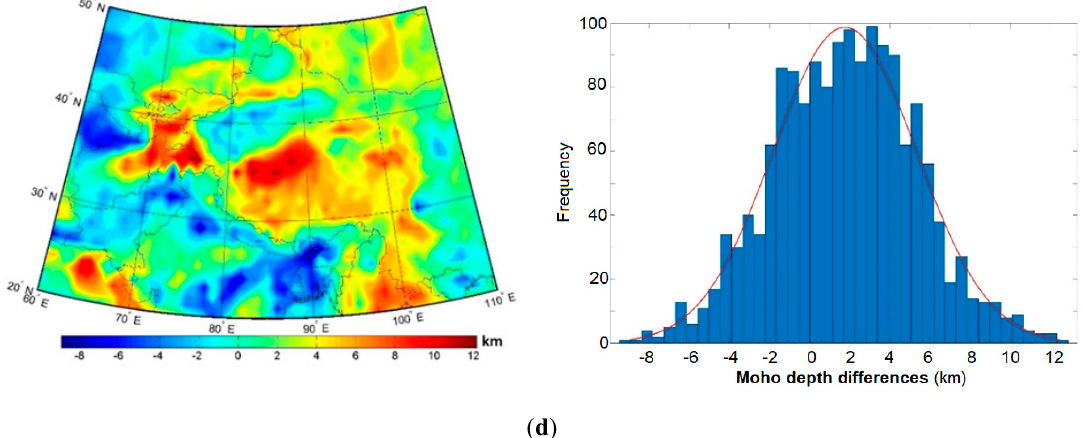
Figure 5. Moho depth differences: ( a ) seismic vs. combined, ( b ) seismic vs. CRUST1.0, ( c ) gravimetric vs. CRUST1.0, and ( d ) combined vs. CRUST1.0.